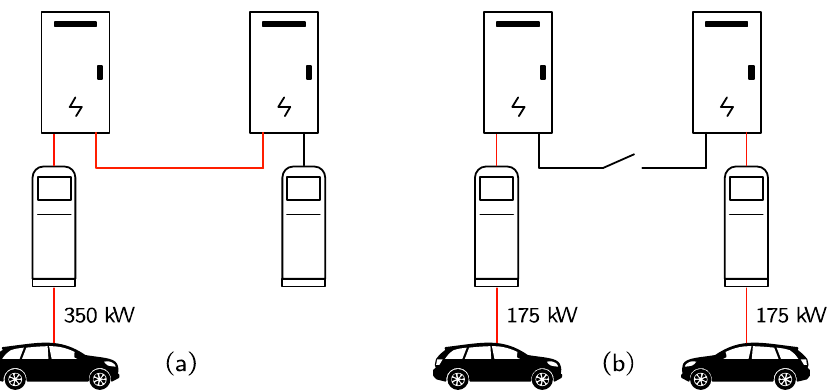
Figure 13. ( a ) Max charging dedicated to premium electric vehicle at up to 350 kW on either charge